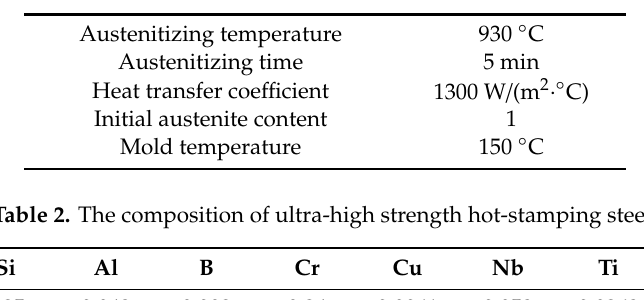
Table 1. The parameters used in the simulation.